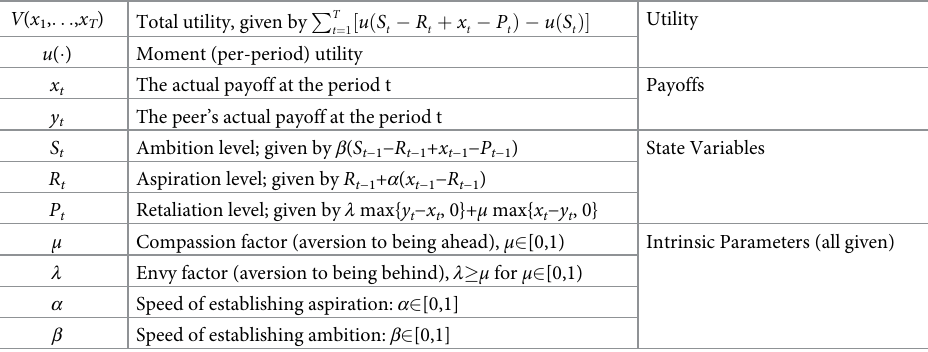
Table 1. Notation for setup and preference parameters in the WB model. V ( x 1 , ... , x T